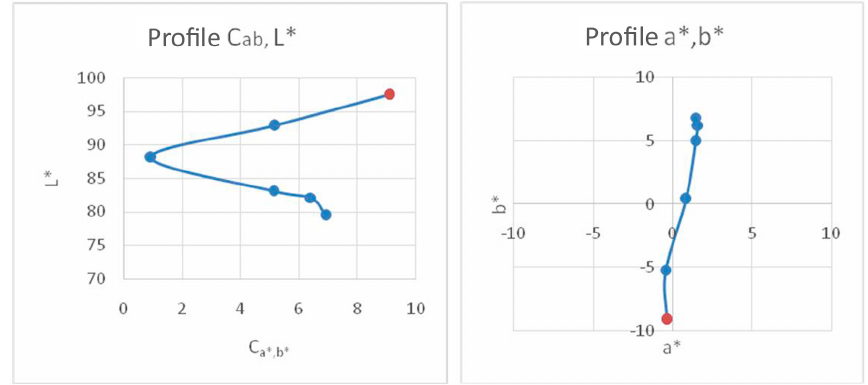
Figure 21. Tone profiles (a*,b*) and Chroma/Clarity for the six measurement geometries.